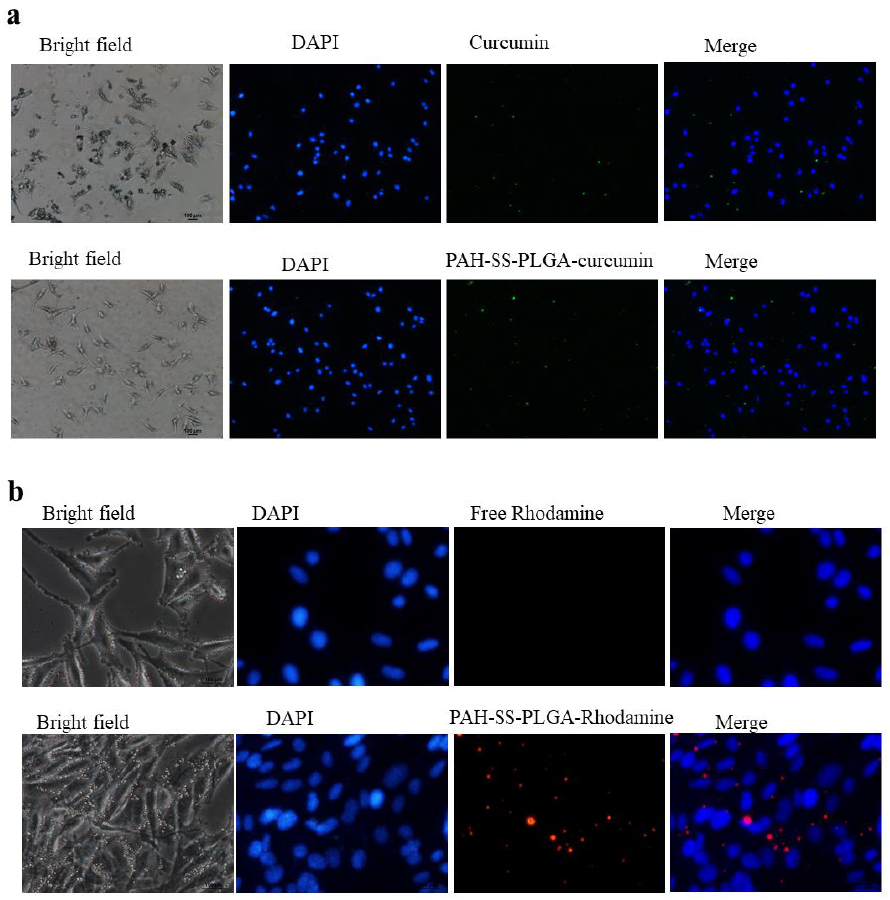
Figure 6. Cellular uptake of ( a ) free curcumin and curcumin-loaded micelles as well as ( b ) free rhodamine and rhodamine-loaded micelles using confocal microscopy after incubating for 3 h. Scalebar is 100 μm.